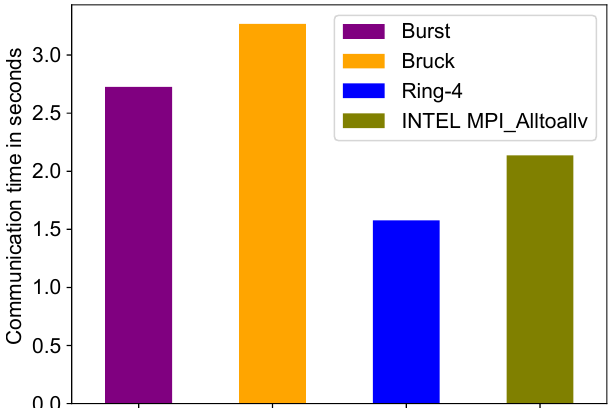
Figure 6. Actual communication time of transposition for the spec- tral transform method with 10 4 MPI processes run on the Beaufix cluster in Météo